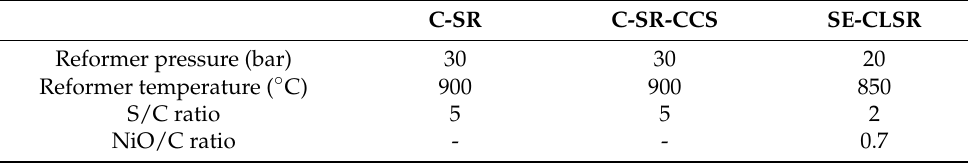
Table 5. Design basis for economic comparisons.